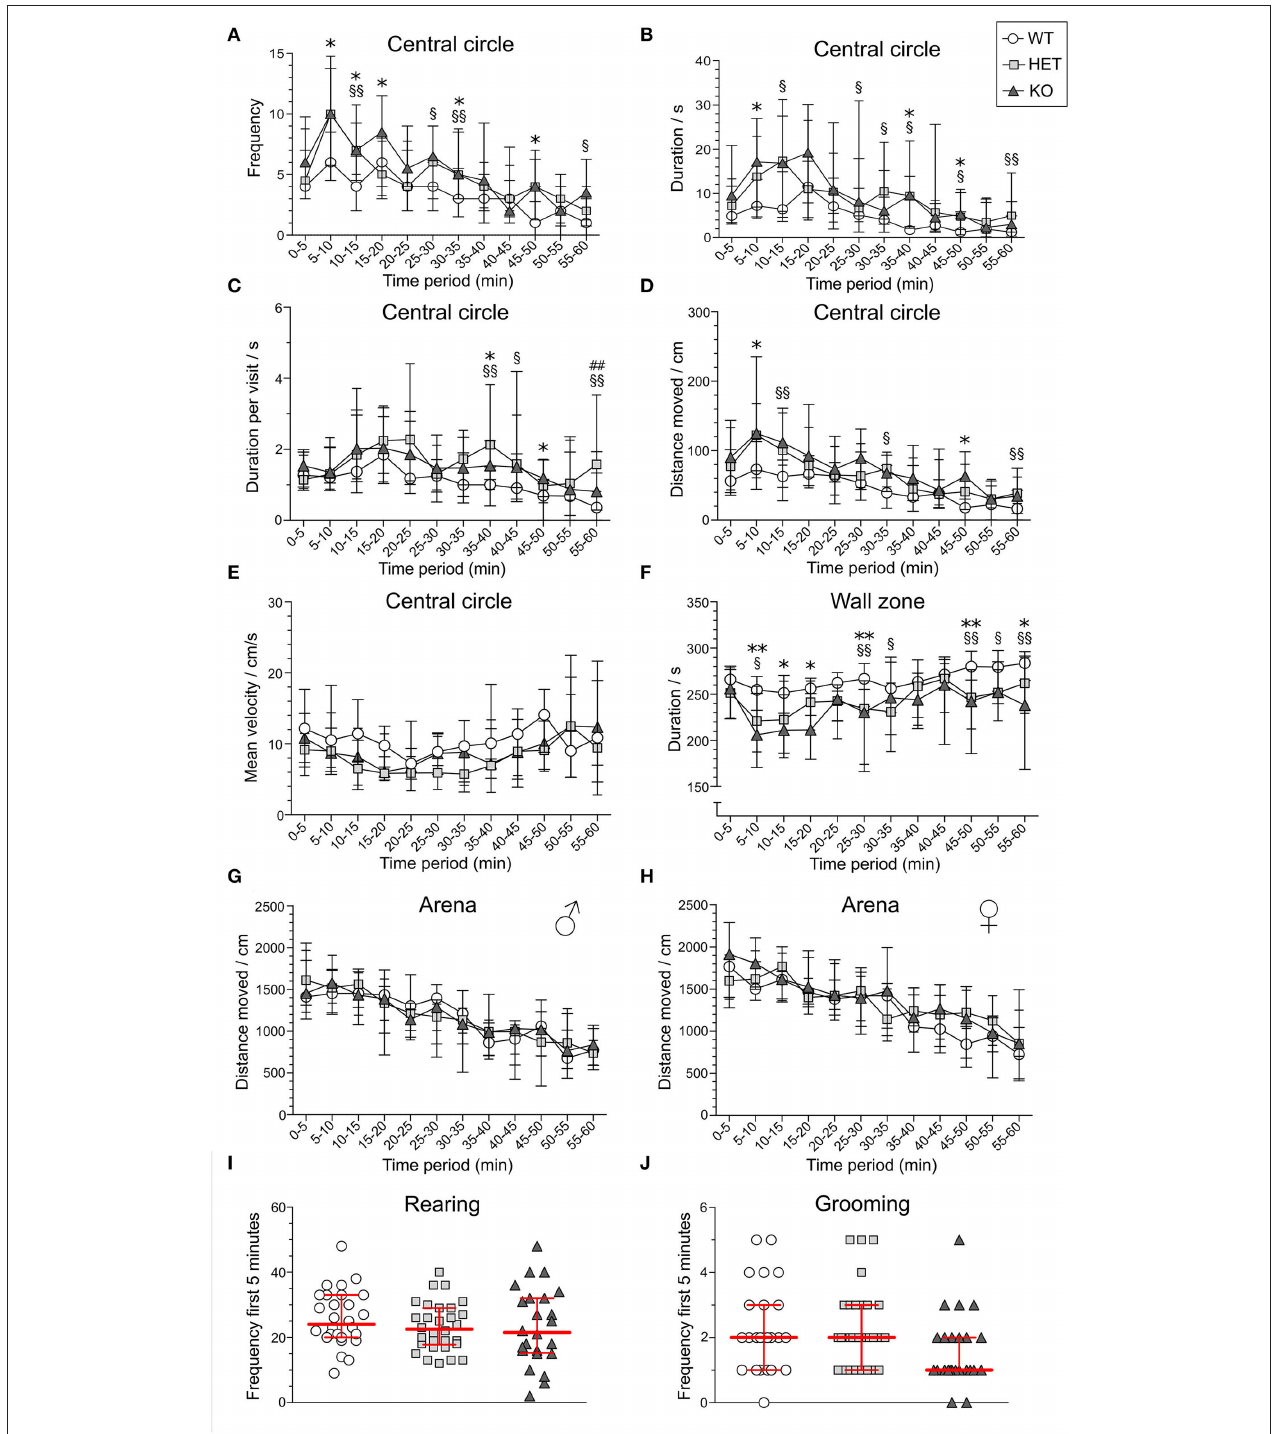
FIGURE 3 | Behavior of SLC38A10-deficient mice in the open field (OF) test. Mice explored the arena for 60min [ n = 25 WT, 28 HET, 18 KO in (A–D,F) ], and behavior in the central circle and wall zone was divided into 5min time bins for (A) frequency, (B) duration (s), (C) duration per visit (s), (D) total distance (cm) moved and (E) mean velocity (cm/s) in the central circle ( n = 10 WT, 19 HET, 10 KO), (F) duration (s) in wall zone, (G,H) total distance (cm) moved in the arena [ n (males) = 13 WT, 14 HWT, 9 KO; n (females) = 12 WT, 14 HET, 9 KO], (I) number of rearings, and (J) number of grooming actions during the first 5min of the test ( n = 28 WT, 30 HET, 24 KO). In (E) , only animals that entered the central circle at least once per time-point were analyzed, which is why the number of animals is lower for this parameter. Data are illustrated as medians with interquartile range. Statistical differences between KO and WT mice are indicated with an asterisk sign (*), between HET and WT mice with a section sign (§) and between HET and KO mice with a hash sign (#), */§ p < 0.05, **/§§## p < 0.01 ( post-hoc Mann–Whitney U -test).